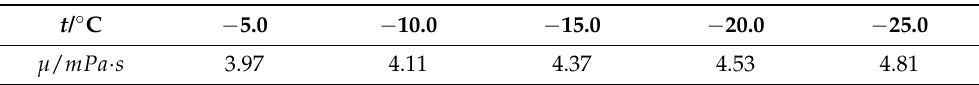
Table 5. Viscosity of FR-1 refrigerant